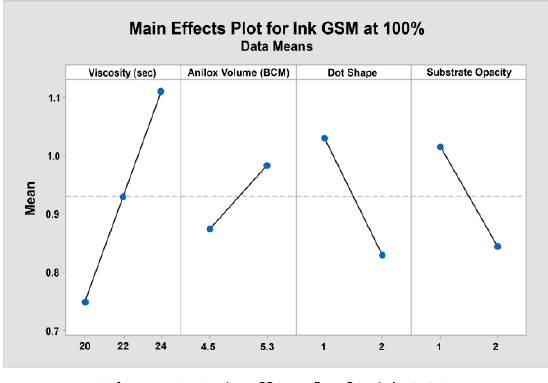
Figure 4. Main effect plot for ink GSM